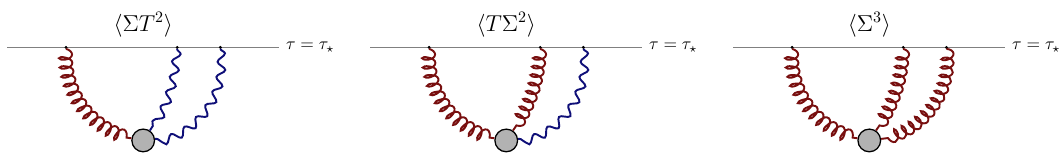
Figure 3 . Wavefunction diagrams arising from interactions between the graviton and a partially massless spin-2 field. When combined with a mixing term massless field to imprint itself on